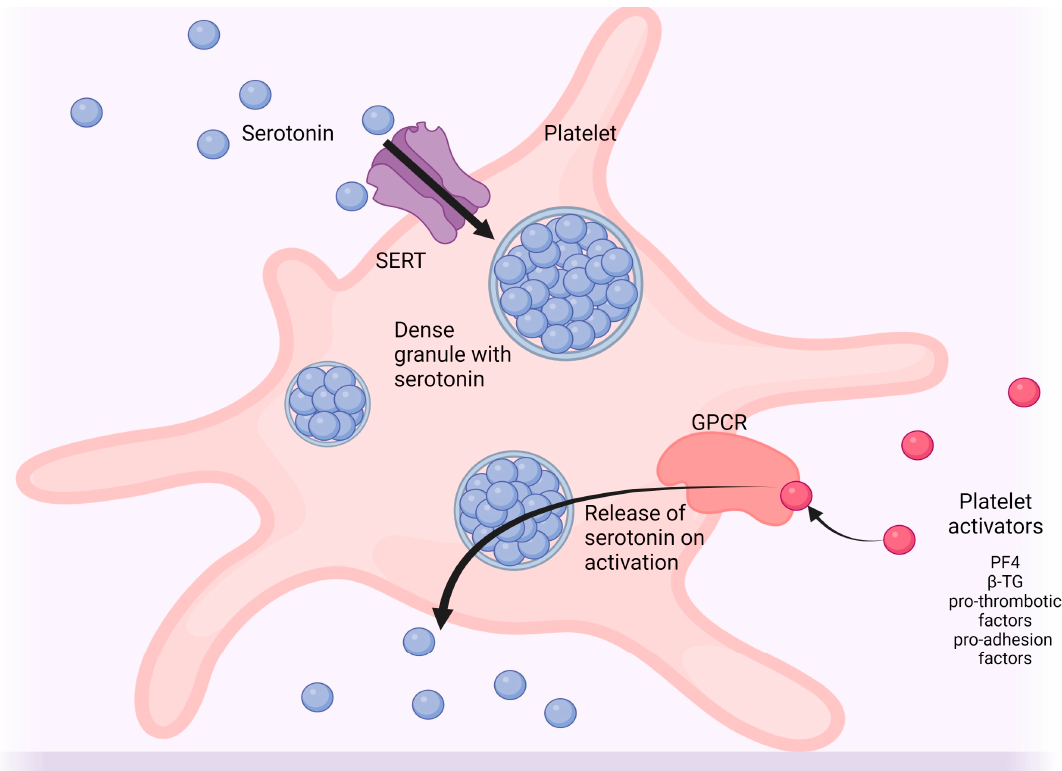
Figure 2. Uptake and release of serotonin by blood platelets. Serotonin is taken up from the bloodstream by the serotonin transporter (SERT) channels where they are stored in dense granules in blood platelets. When platelets are activated by platelet activators, such as platelet factor 4 (PF4), pro-thrombotic factors, pro-adhesion proteins, or β -thromboglobulin ( β -TG) (among others), binding of the platelet activators to G-protein coupled receptors (GPCR) at the cell surface trigger a cascade of events which result in the release of serotonin from platelets into the periphery. Created with BioRender.com .